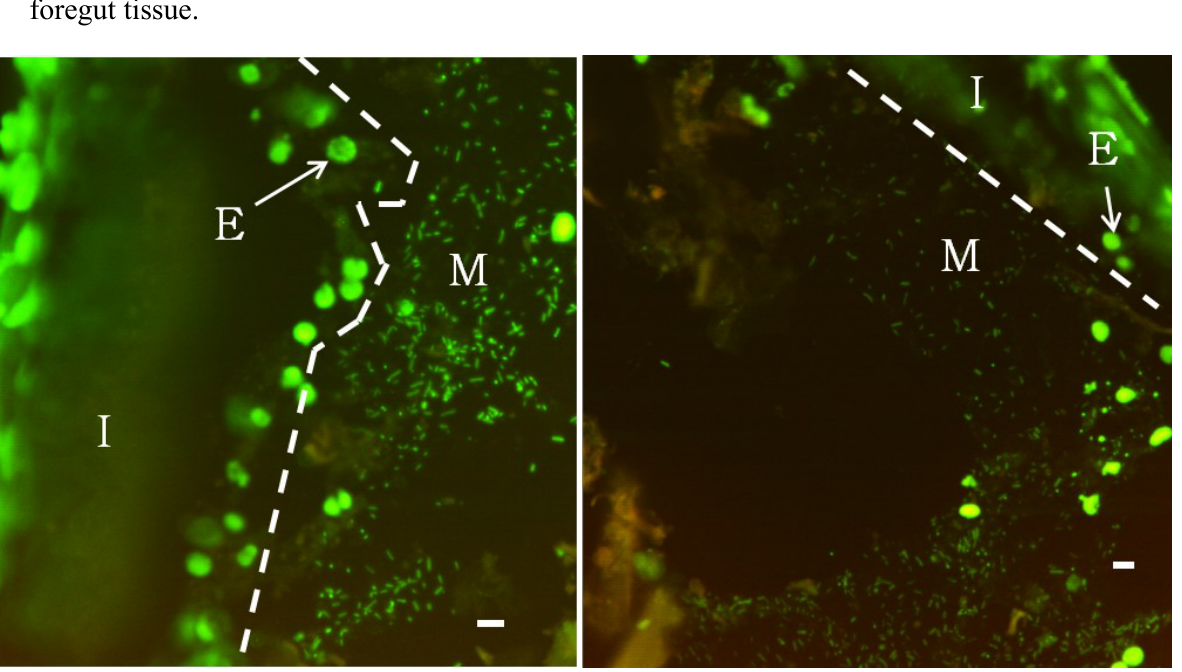
Figure 1. Epifluorescence microscopy of SYBR Green stained semi-thin serially sectioned foregut